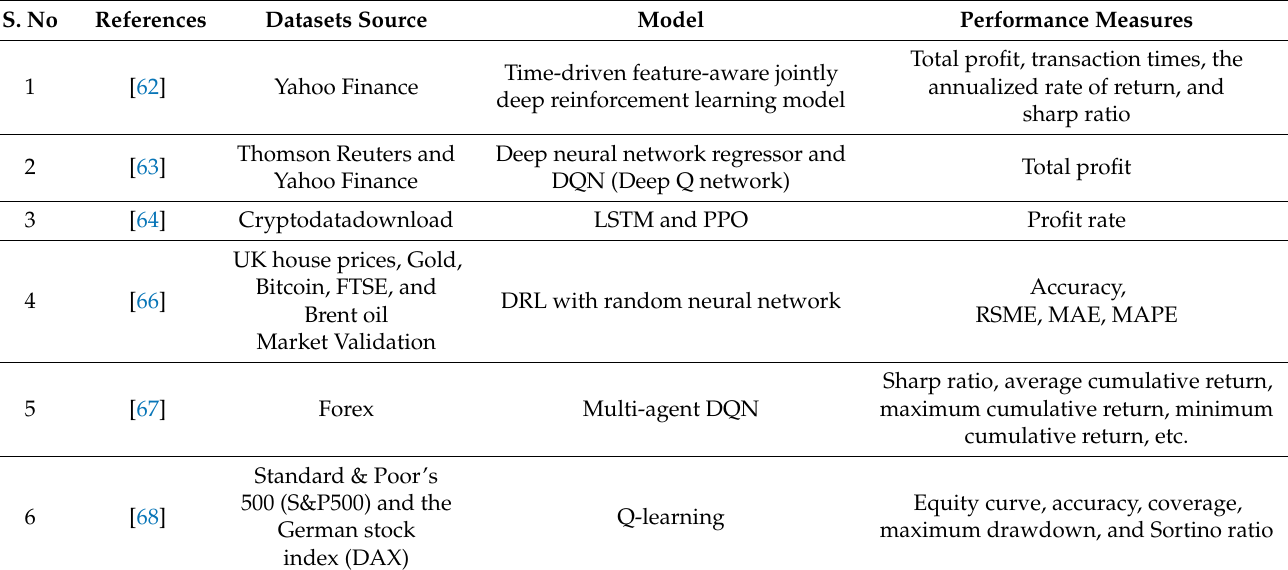
Table 3. Reinforcement learning applications in